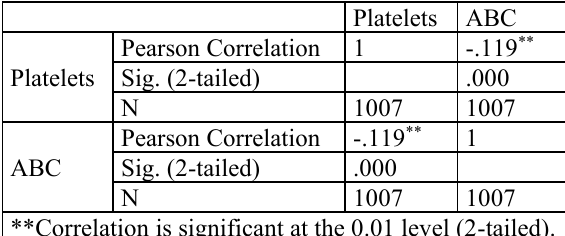
Table-3: Correlation between ABC